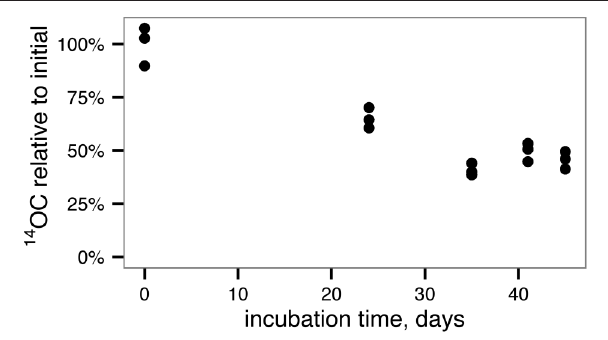
FIGURE 1 | Degradation of 14 C-labeled, phytoplankton-derived OM by an estuarine microbial community yields relatively recalcitrant, 14 C-labeled OM for use in microcosm